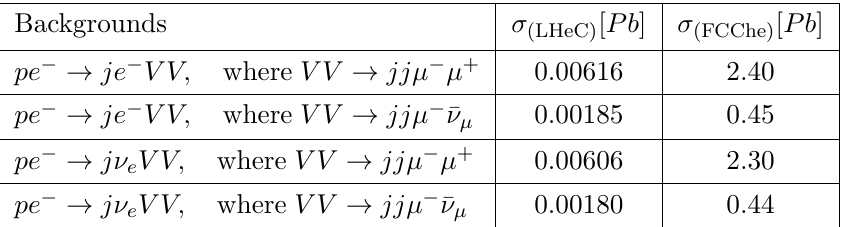
Table 1 . Dominant background processes considered in our analysis and their total cross sections. The samples have been produced with the following cuts: P T ( j ) (cid:21) 5 GeV, P T ( l ) (cid:21) 2 GeV and j (cid:17) ( l=j ) j (cid:20) 4 :